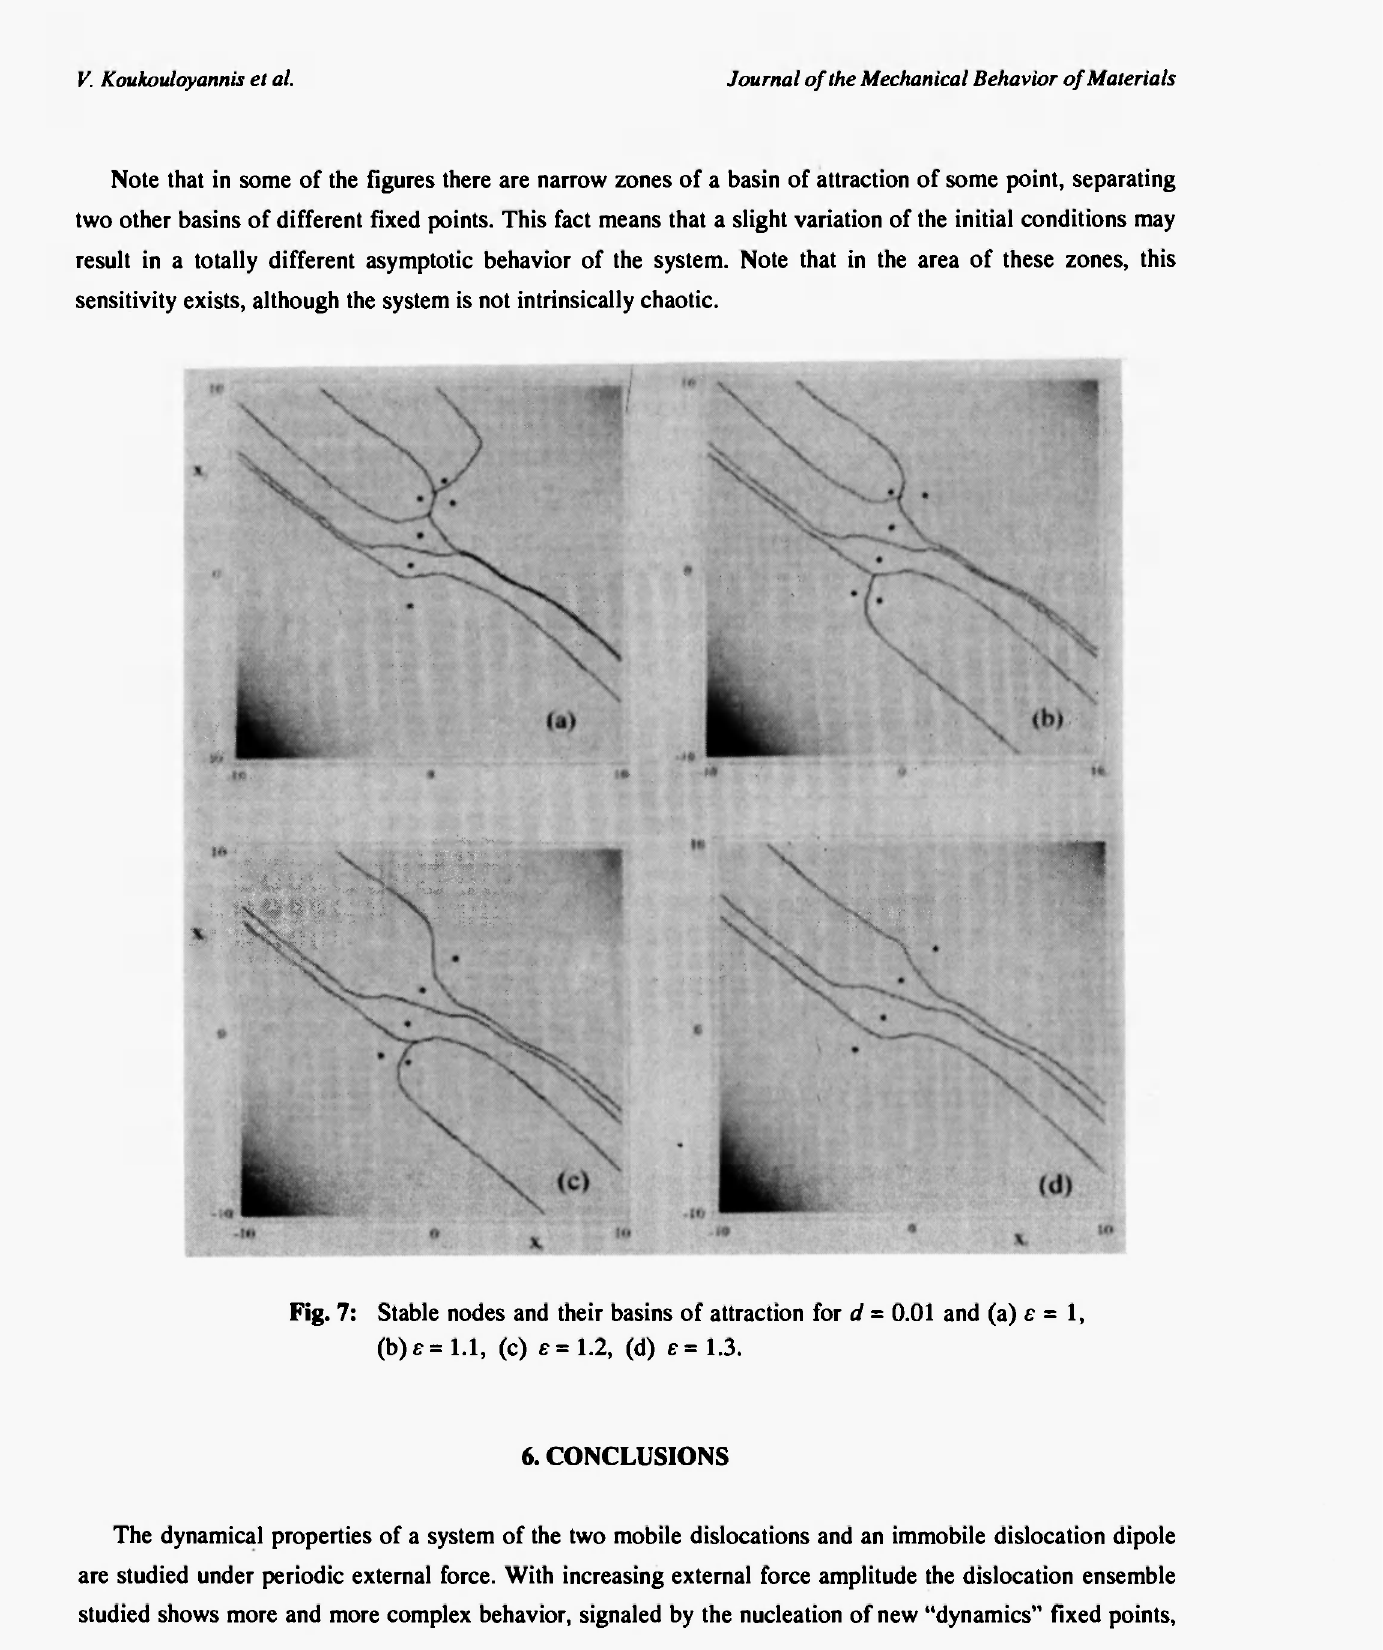
Fig. 7: Stable nodes and their basins of attraction for d = 0.01 and (a) ε = 1, (b)es 1.1, (c) c= 1.2, (d) c=